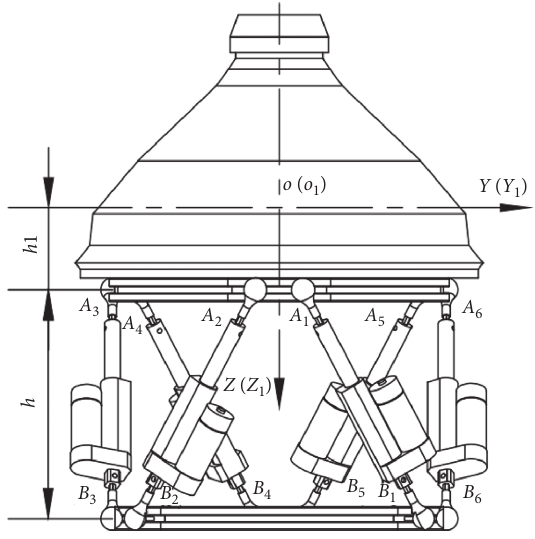
Figure 2: The model of